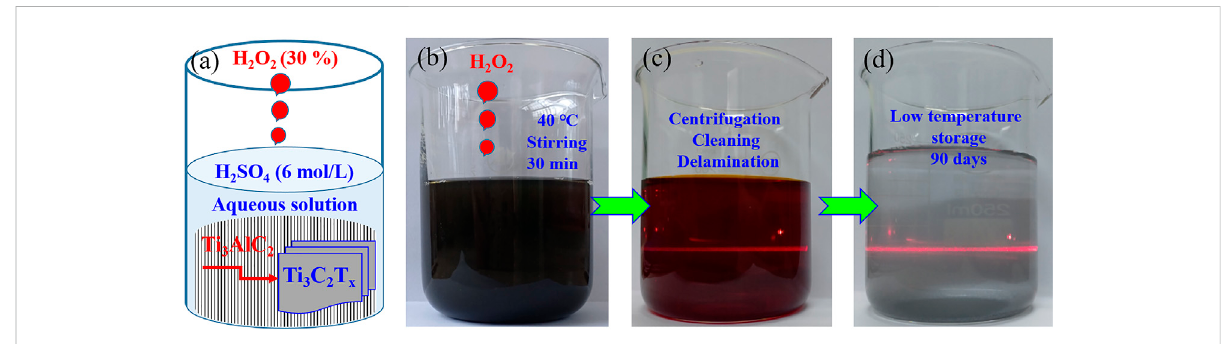
FIGURE 1 Ti 3 C 2 T x nanosheets prepared byselectiveetching in asystem ofH 2 SO 4 and H 2 O 2 . Schematicillustrationofapreparation procedure inabeaker (A) . Digital photographs of a mixture of Ti 3 AlC 2 powders and aqueous H 2 SO 4 solution (B) , aqueous MXenes solution after Al layers etching (C) , and aqueous MXenes solution after delamination (D) .